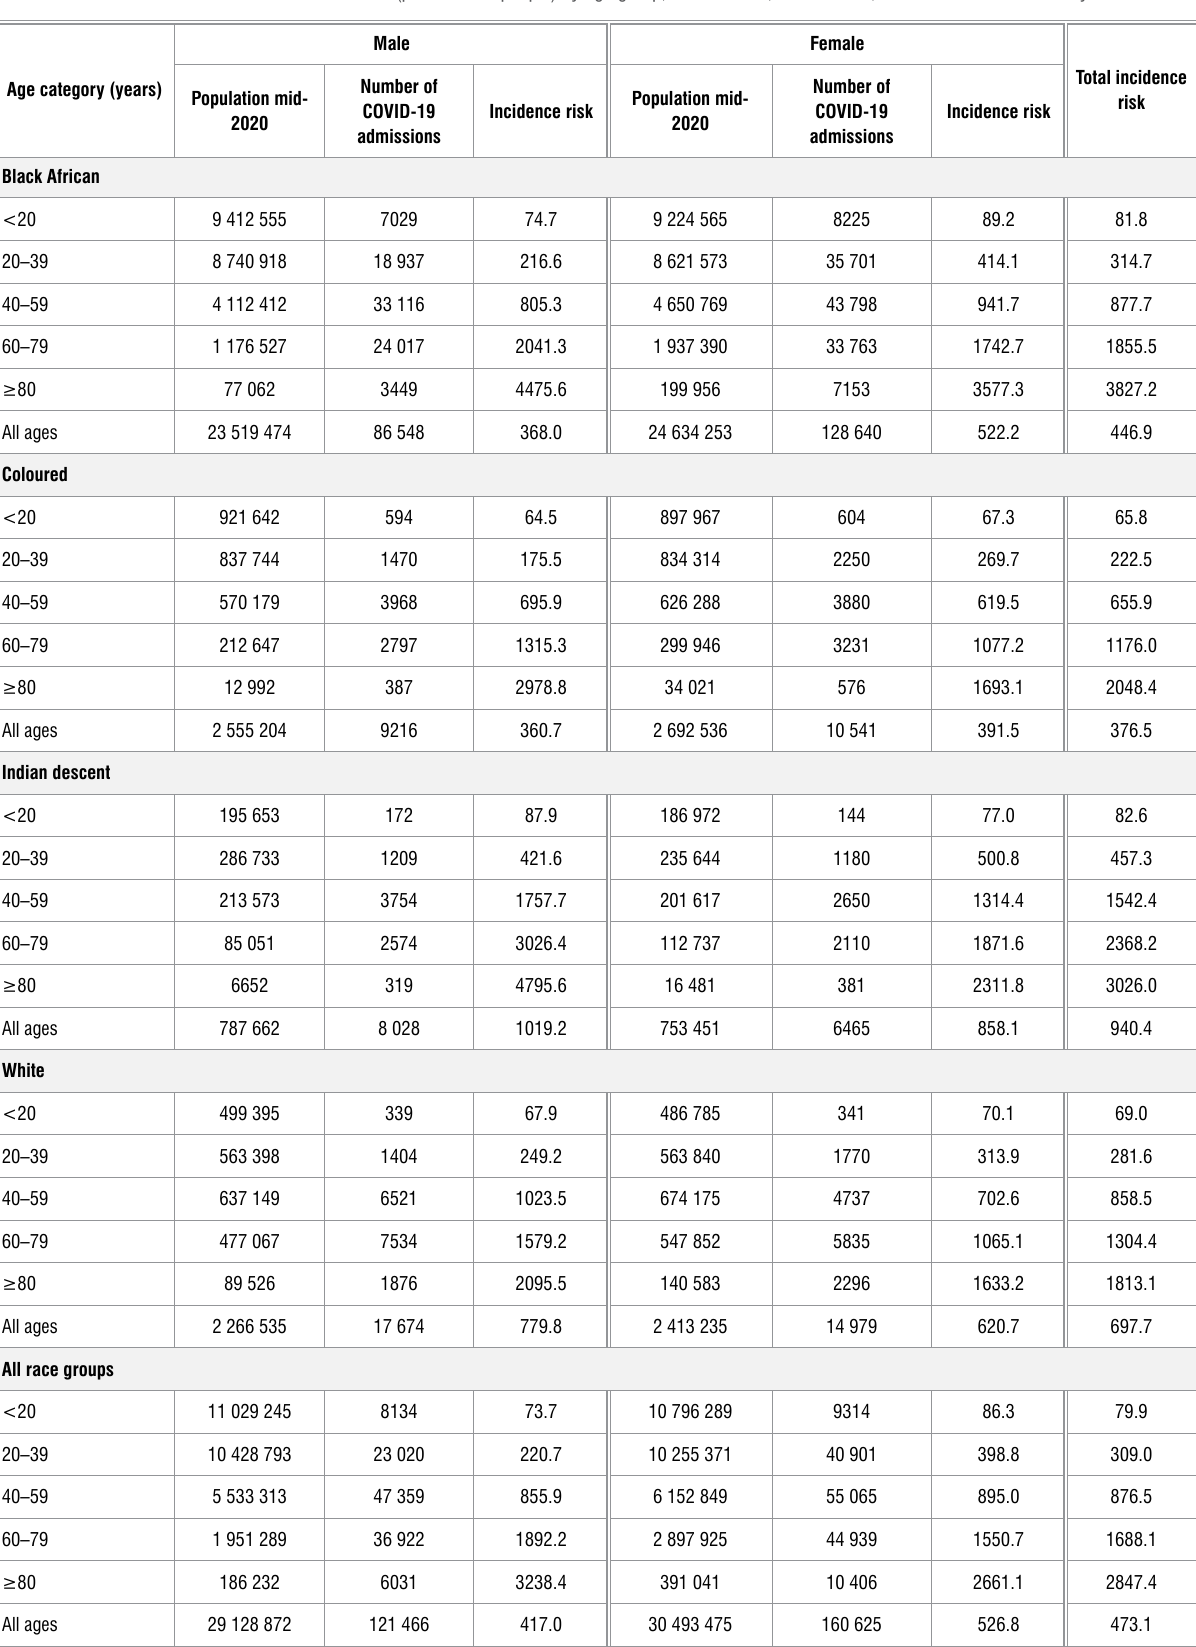
Table 2: Incidence risk of COVID-19 admissions (per 100 000 people) by age group, sex and race, South Africa, 5 March 2020 to 8 January